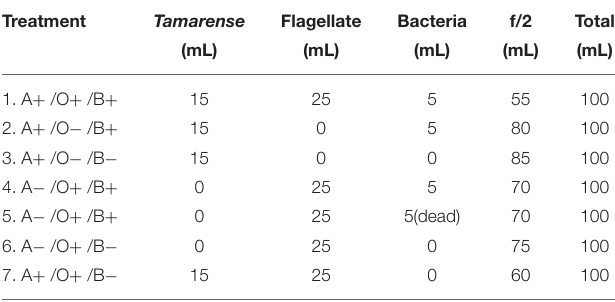
TABLE 1 | Different assemblage setups for